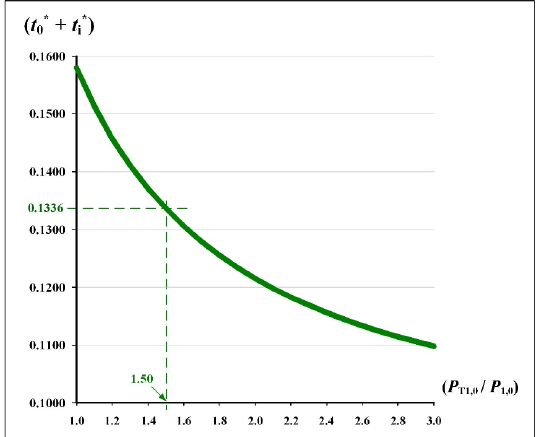
Fig. 14. Impact of ( P T1,0 / P 1,0 ) on